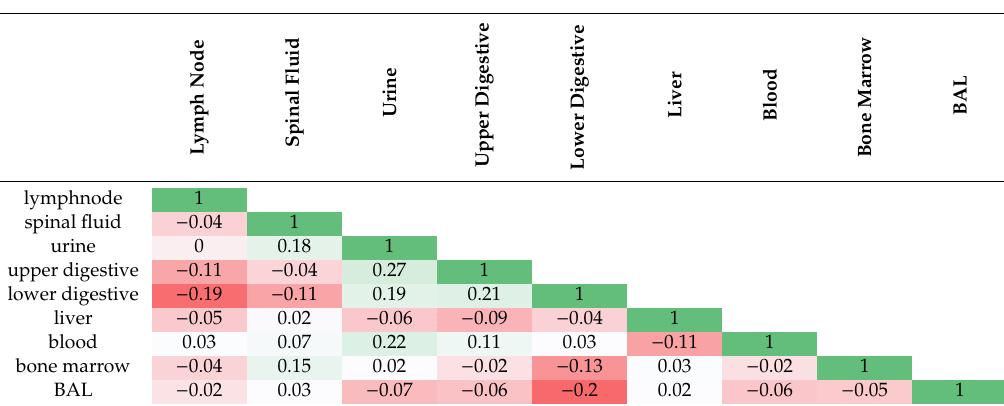
Table 5. Pairwise correlation matrix between sites being sampled to try to identify the pathogen.